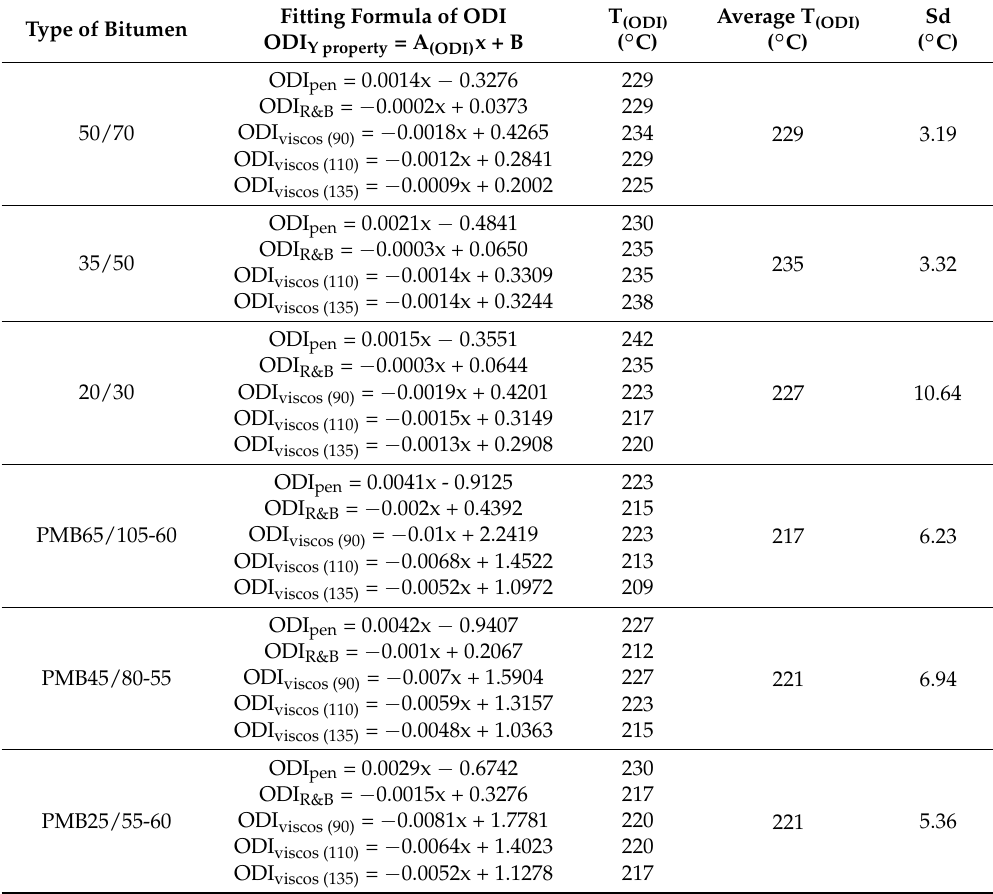
Table 3. Overheating limit temperatures T (ODI) for modified and non-modified bituminous binders, before and after heating at a high temperature (1